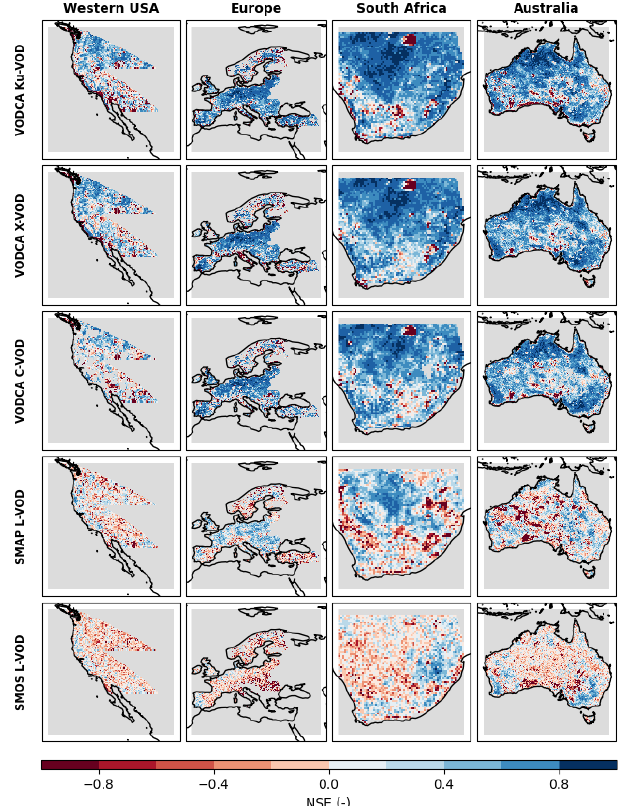
Figure 3. Nash–Sutcliffe model efficiency coefficient (NSE) per pixel for the global random forest model (PFTs included as pre- dictor) based on monthly values. Rows indicating results for the different VOD datasets and columns indicating the different regions as dictated by the availability of the LFMC dataset. The shape of the western USA region is determined by the used h08v04, h08v05, and h09v04 MODIS tiles which form the basis for the retrieval of the LFMC